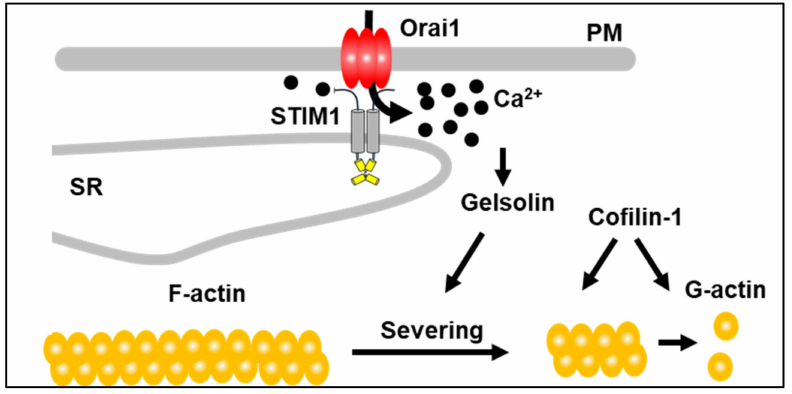
Figure 6. Regulation of cytoskeleton density by STIM1. Explanation in the